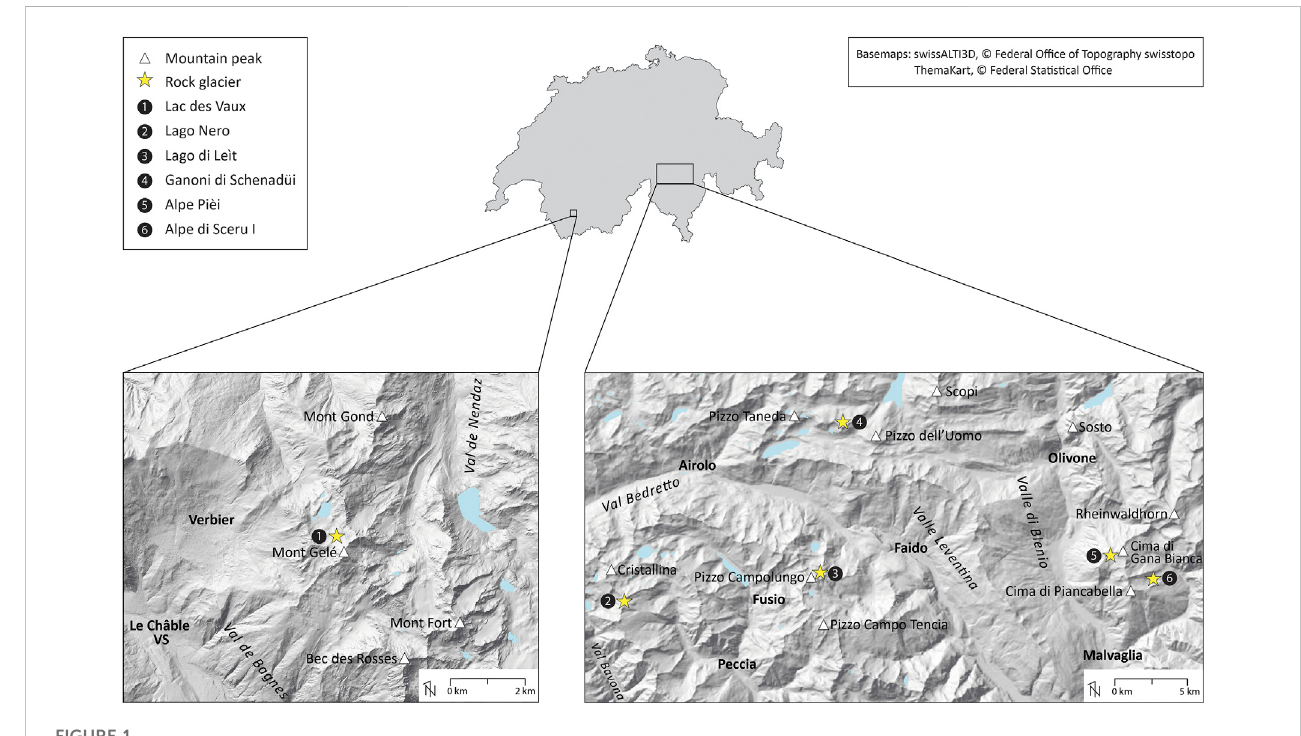
FIGURE 1 Location of the rock glaciers investigated in this study.